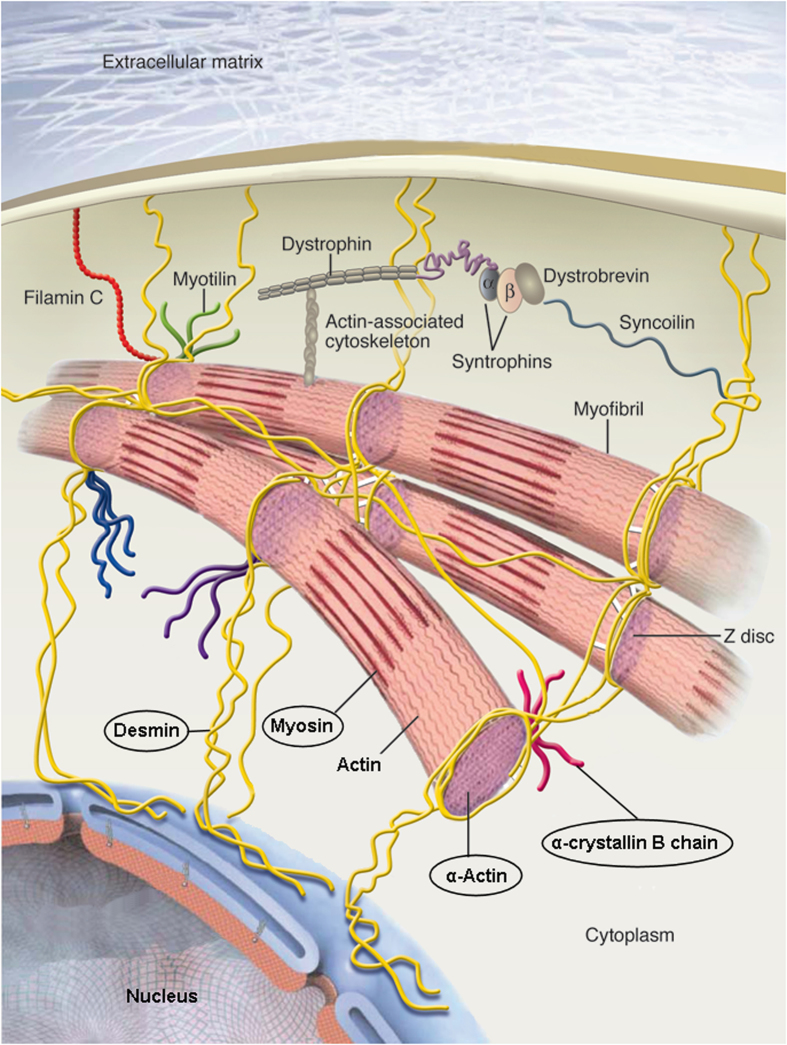
A basic structure of a myocyte.Actin and myosin are the major proteins in the contractile apparatus; the sarcomere. Desmin are predominantly found around the Z-disc linking the myofibrils together. Alpha-crystallin B chain binds to other cytoskeletal and myofibrillar proteins thus having a stabilizing effect. Adapted with permission from The Journal of Clinical Investigation77.